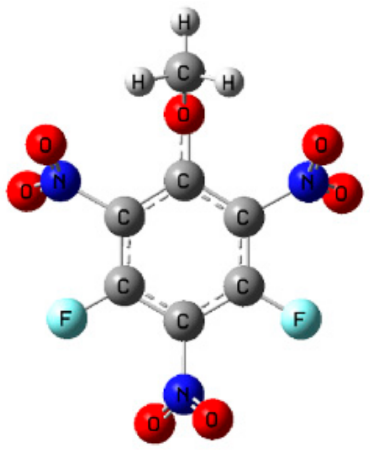
Figure 1. Chemical structure of